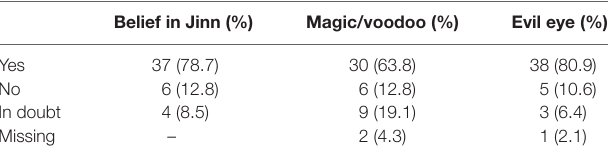
TaBle 1 | Attribution styles ( n =